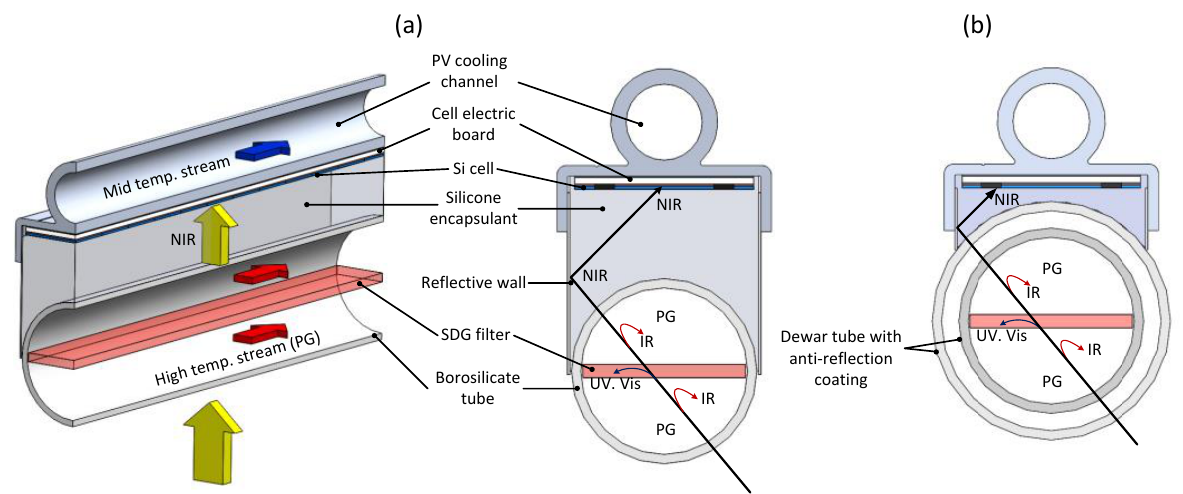
Figure 12: High-temperature hybrid beam splitting PV-T receiver for linear solar concentrators developed by RMIT University. (a) Design experimentally tested. (b) Proposed modified design featuring vacuum insulation between the two tubes to enhance thermal output. The outer surface of the inner tube should also have a lower coating to minimize radiative losses.